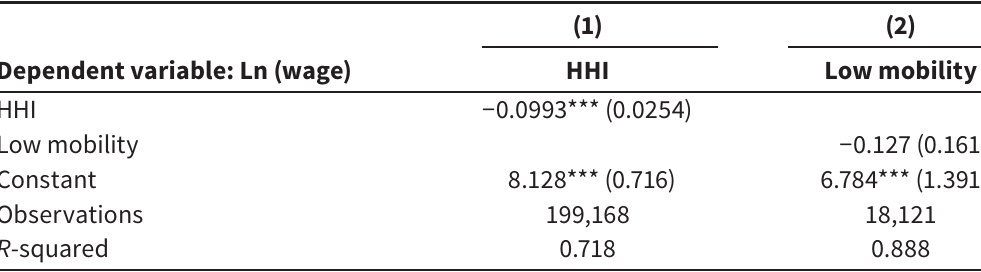
Effects of the HHI and low mobility on the log of teenage wages (1) Dependent variable: Ln (wage) HHI Low mobility HHI −0.0993*** (0.0254) Low mobility −0.127 (0.161) Constant Observations 199,168 18,121 R -squared 0.718 0.888 Robust clustered standard errors in parentheses by